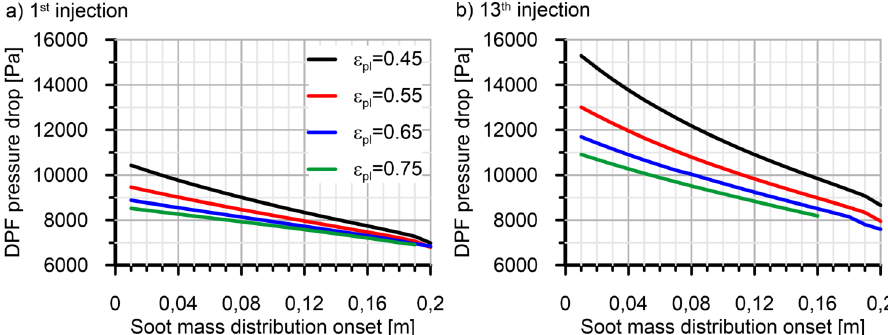
Figure 7. Impact of the onset of the soot mass distribution on the DPF pressure drop as a function of the particulate layer porosity and the soot mass loading (number of injections) in DPF #A.